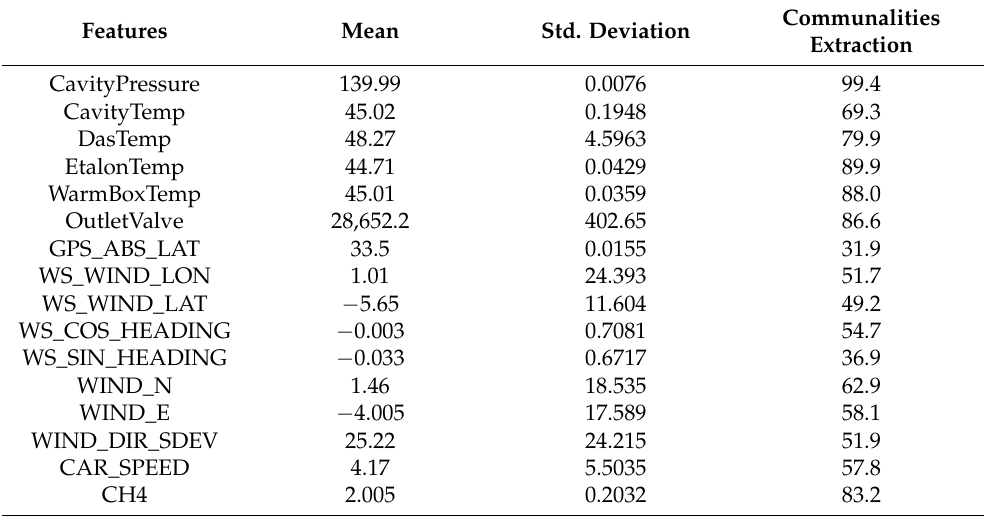
Table 1. Descriptive statistics and communalities of the factor model (N = 69,831, Initial =